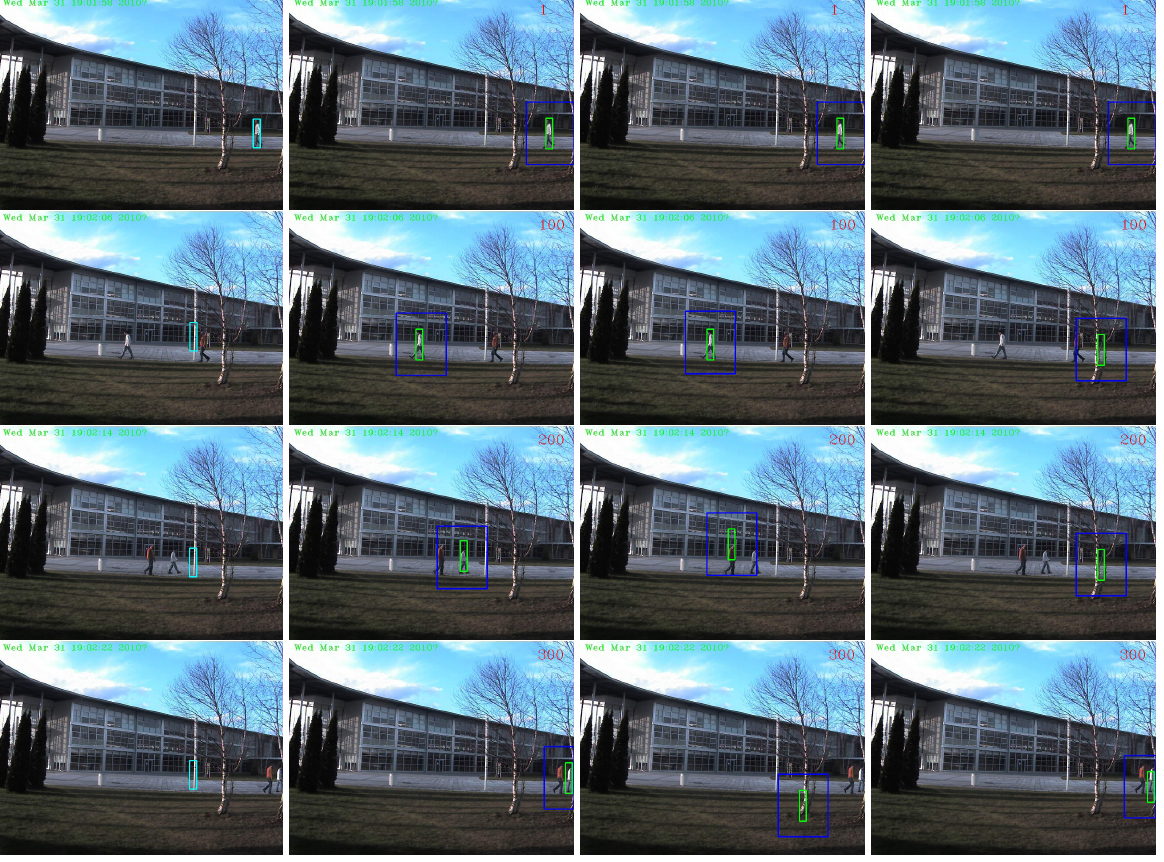
Figure 8. Tracking results on the “White-outdoor” sequence using different update policies. Column 1: “MILTracker”. Column 2: “AdpCov+cu”. Column 3: “AdpCov+nu”. Column 4: “AdpCov+fu”. In the last three columns, the blue rectangles indicate the search windows and the green rectangles are the tracking results. Row 1: Frame #1. Row 2: Frame #100. Row 3: Frame #200. Row 4: Frame